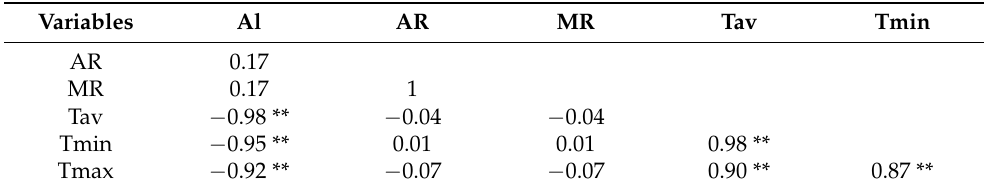
Table 2. Pearson coefficient correlation of several agroclimatic variables such as altitude, temperature and rainfall in four kaffir lime growing locations.